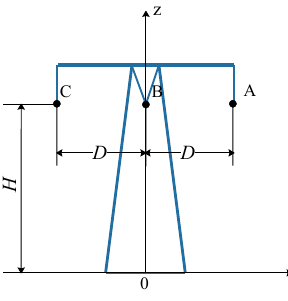
Figure 7. Example of the 220 kV transmission